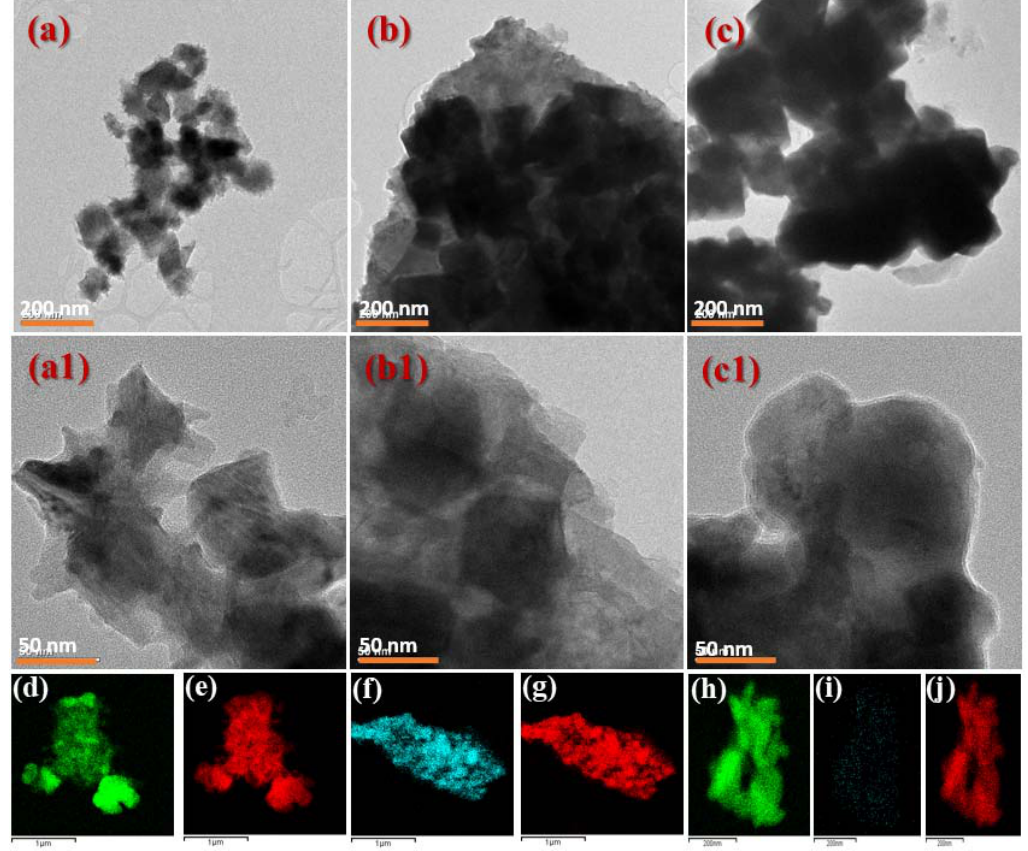
Figure 2. Low magnification ( a – c ) and high-magnification ( a1 – c1 ) TEM images of CuS ( a , a1 ), PbS ( b , b1 ) and CuS@PbS ( c , c1 ) composite on Ni-foam substrate. EDX-TEM image and corresponding elemental mapping of CuS ( d , e ), PbS ( f , g ) and composite ( h – j ).